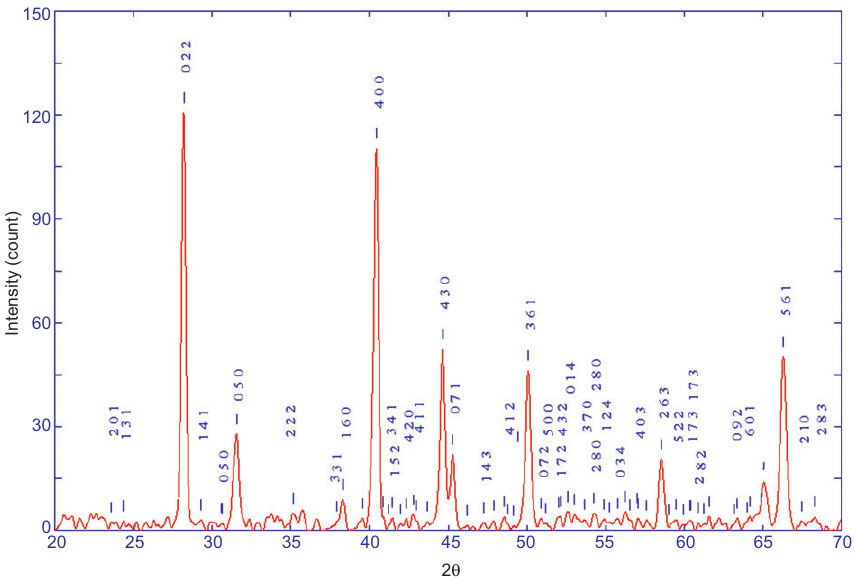
Figure 2 X-ray powder diffraction of the complex { Ga (L 2 )